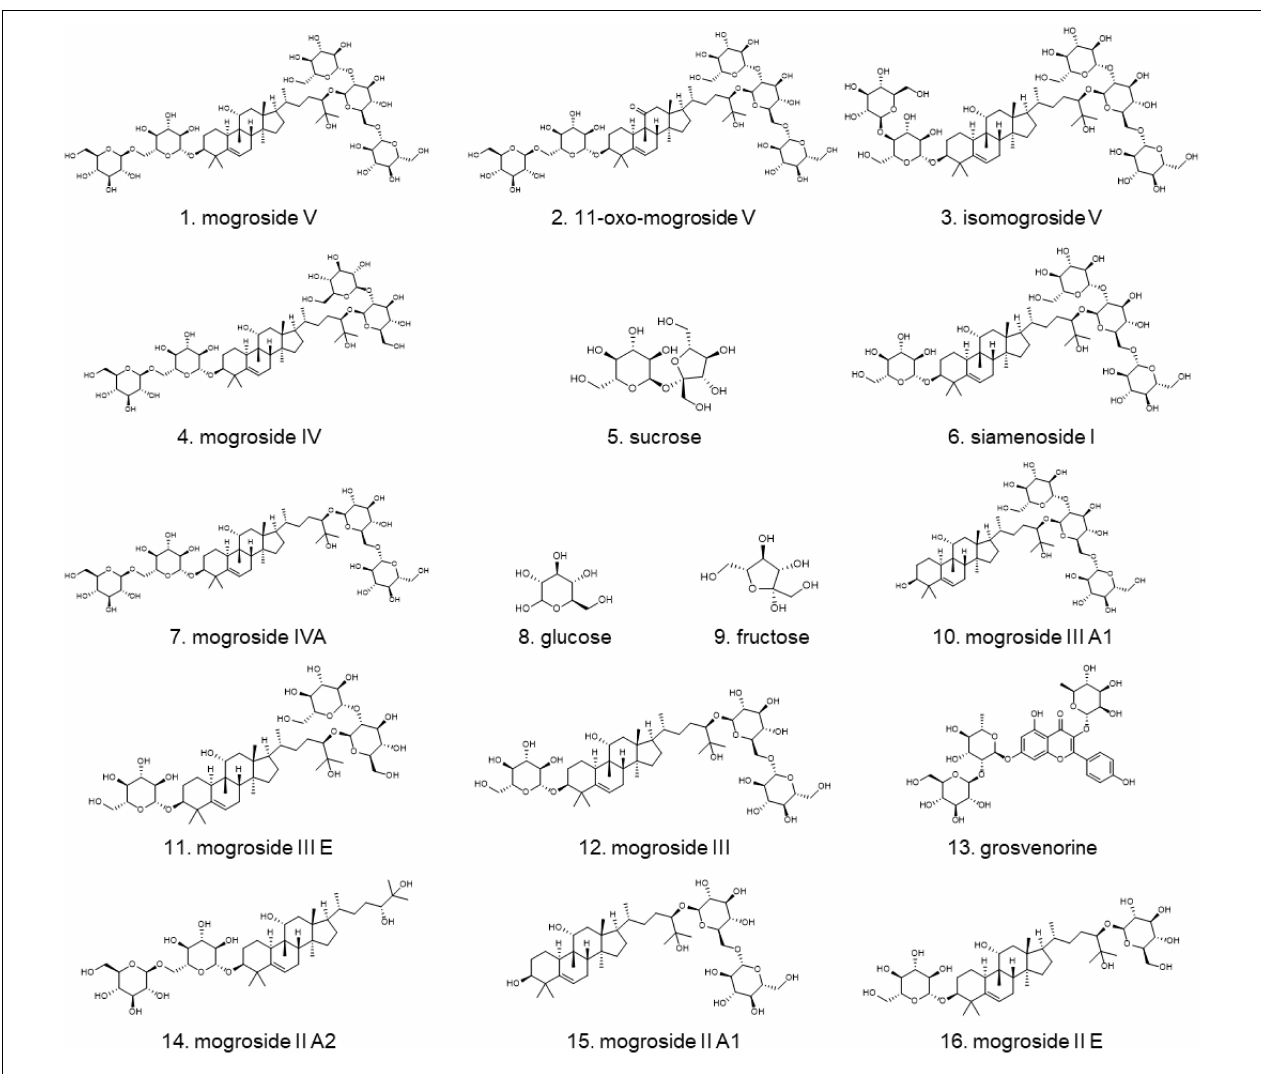
FIGURE 1 | Chemical structures of 16 investigated